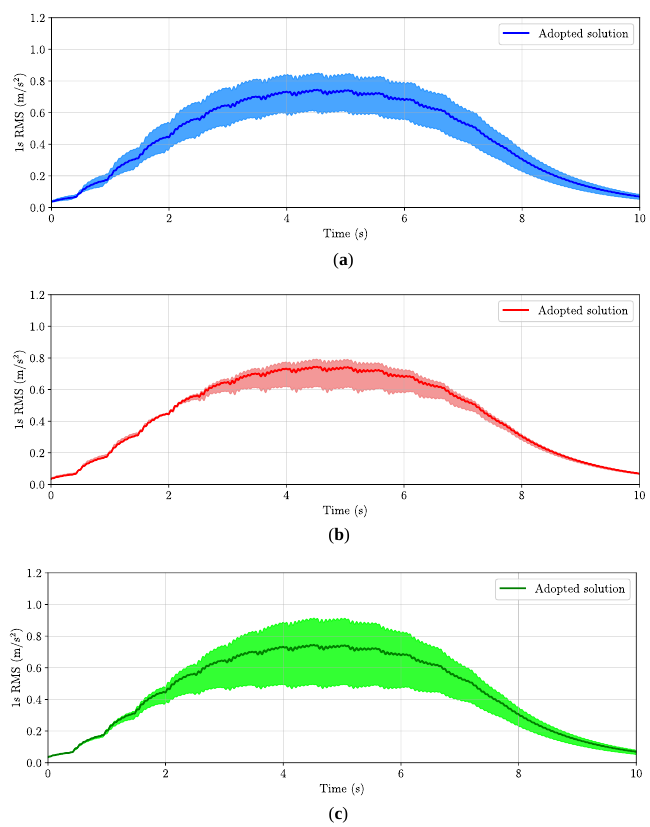
Figure 15. Parametric analysis varying the properties of the human body: ( a ) Mass. ( b ) Frequency. ( c ) Damping ratio.